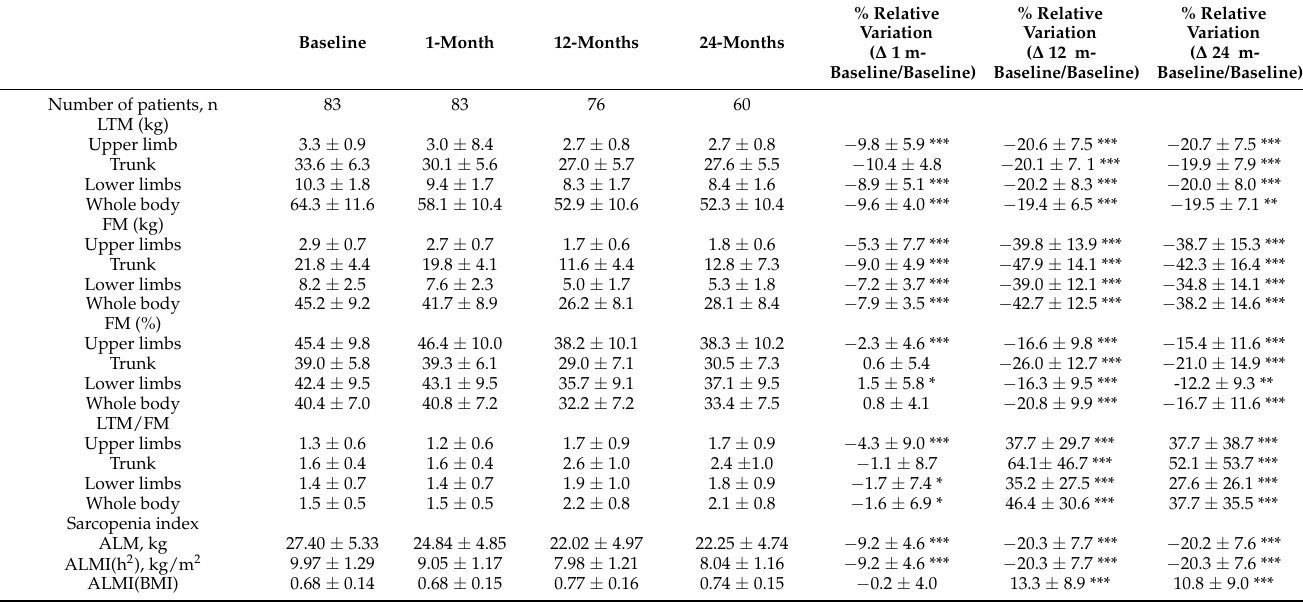
Table 2. Wholebodycompositionofthepatientsatbaselineand1,12and24monthsaftersleevegastrectomy.